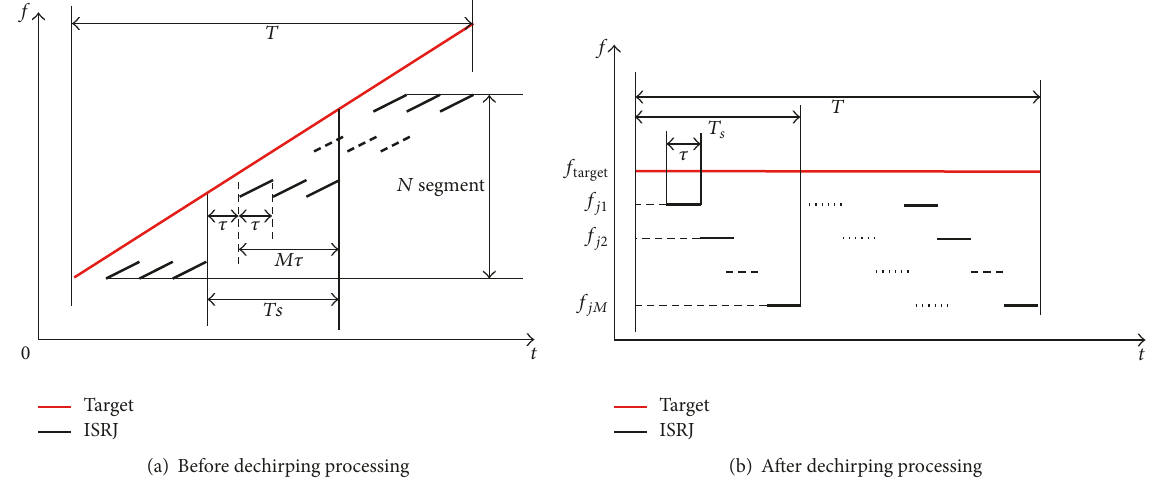
Figure 2: TF distributions of the target echo signal and the ISRJ signal.